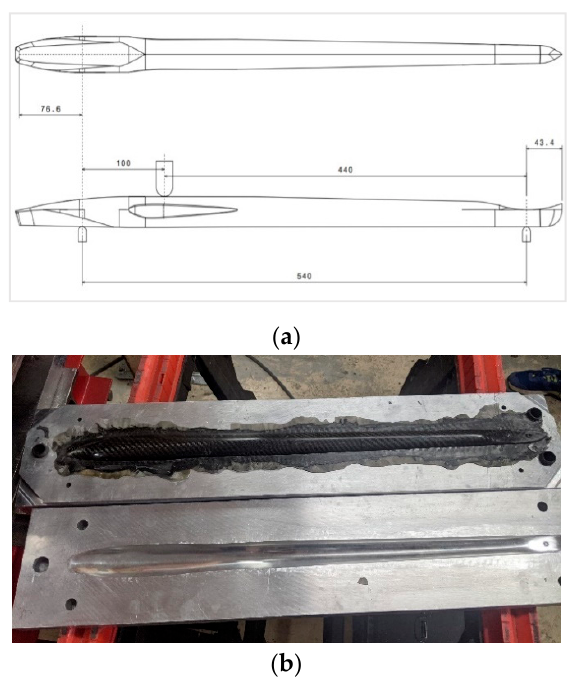
Figure 3. ( a ) 2D sketch of the fuselage, ( b ) Physical machined mould shows two female cavity.